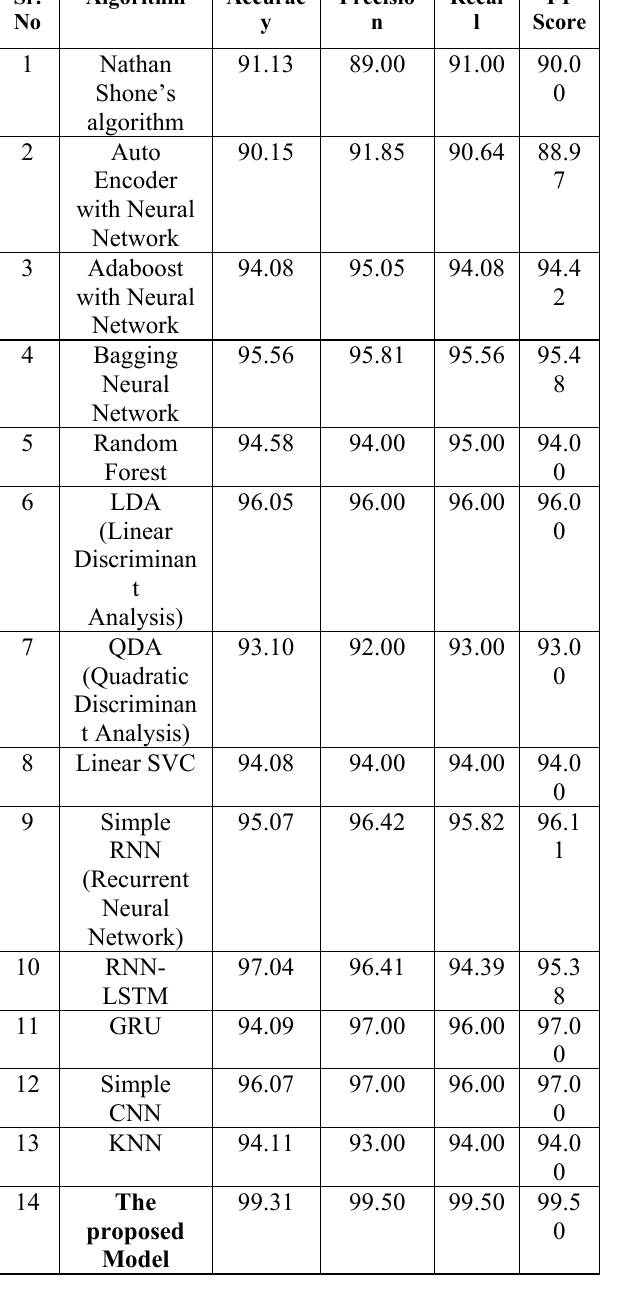
Fig. 6 6-Layer MLP Loss & Accuracy Graph